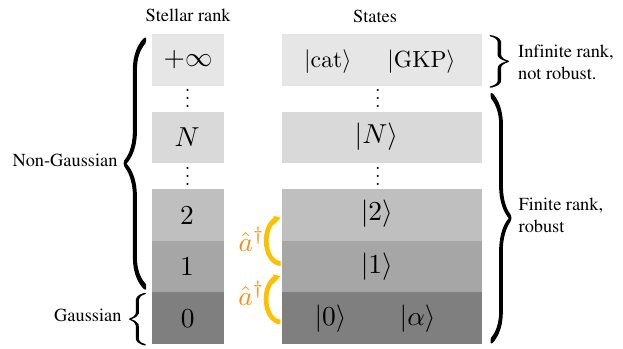
FIG. 2. A pictorial depiction of the stellar hierarchy. The right column gives examples of pure states of each stellar rank, which corresponds to the minimal number of photon additions ˆ a † nec- essary to obtain the state from the vacuum. All states of finite stellar rank are robust, i.e., they have only states of equal or higher stellar rank in their close